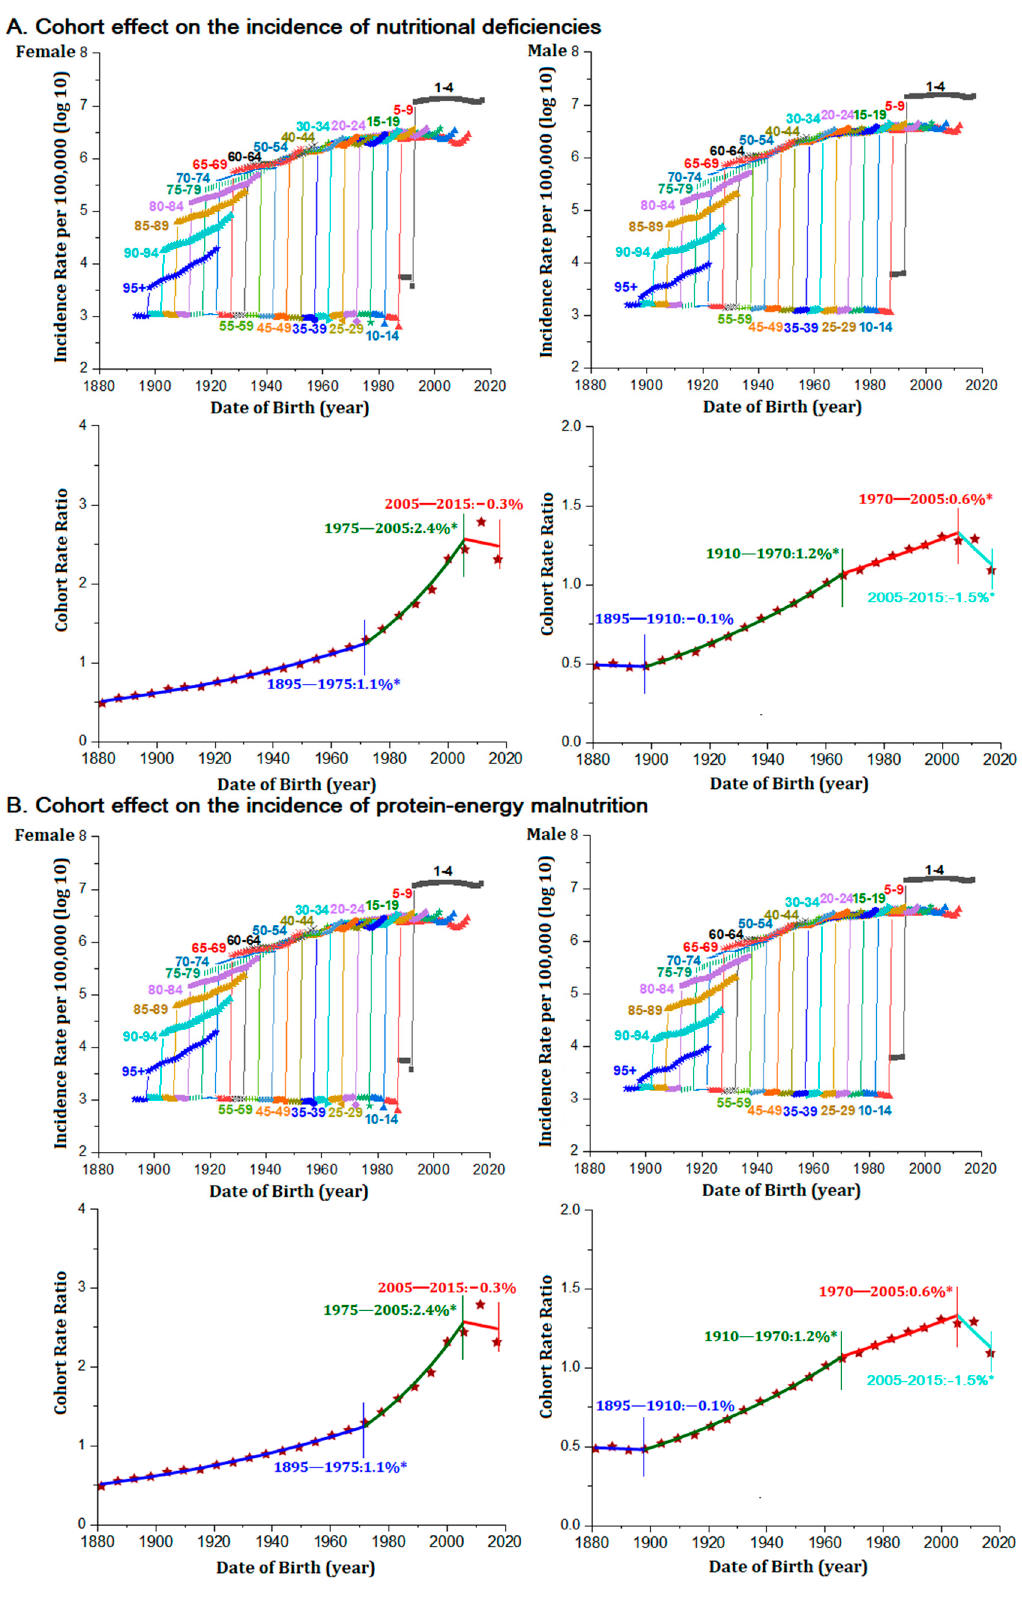
Figure 4. Age-sex specific incidence rates with increased risk across birth cohort and annual percent change of cohort rate ratios in LMICs for nutritional deficiencies and its subcategories. ( A ) Overall nutritional deficiencies. ( B ) Subcategory protein-energy malnutrition. Note: (*) Indicates statistically significant change in each successive birth cohort (p < 0.05).